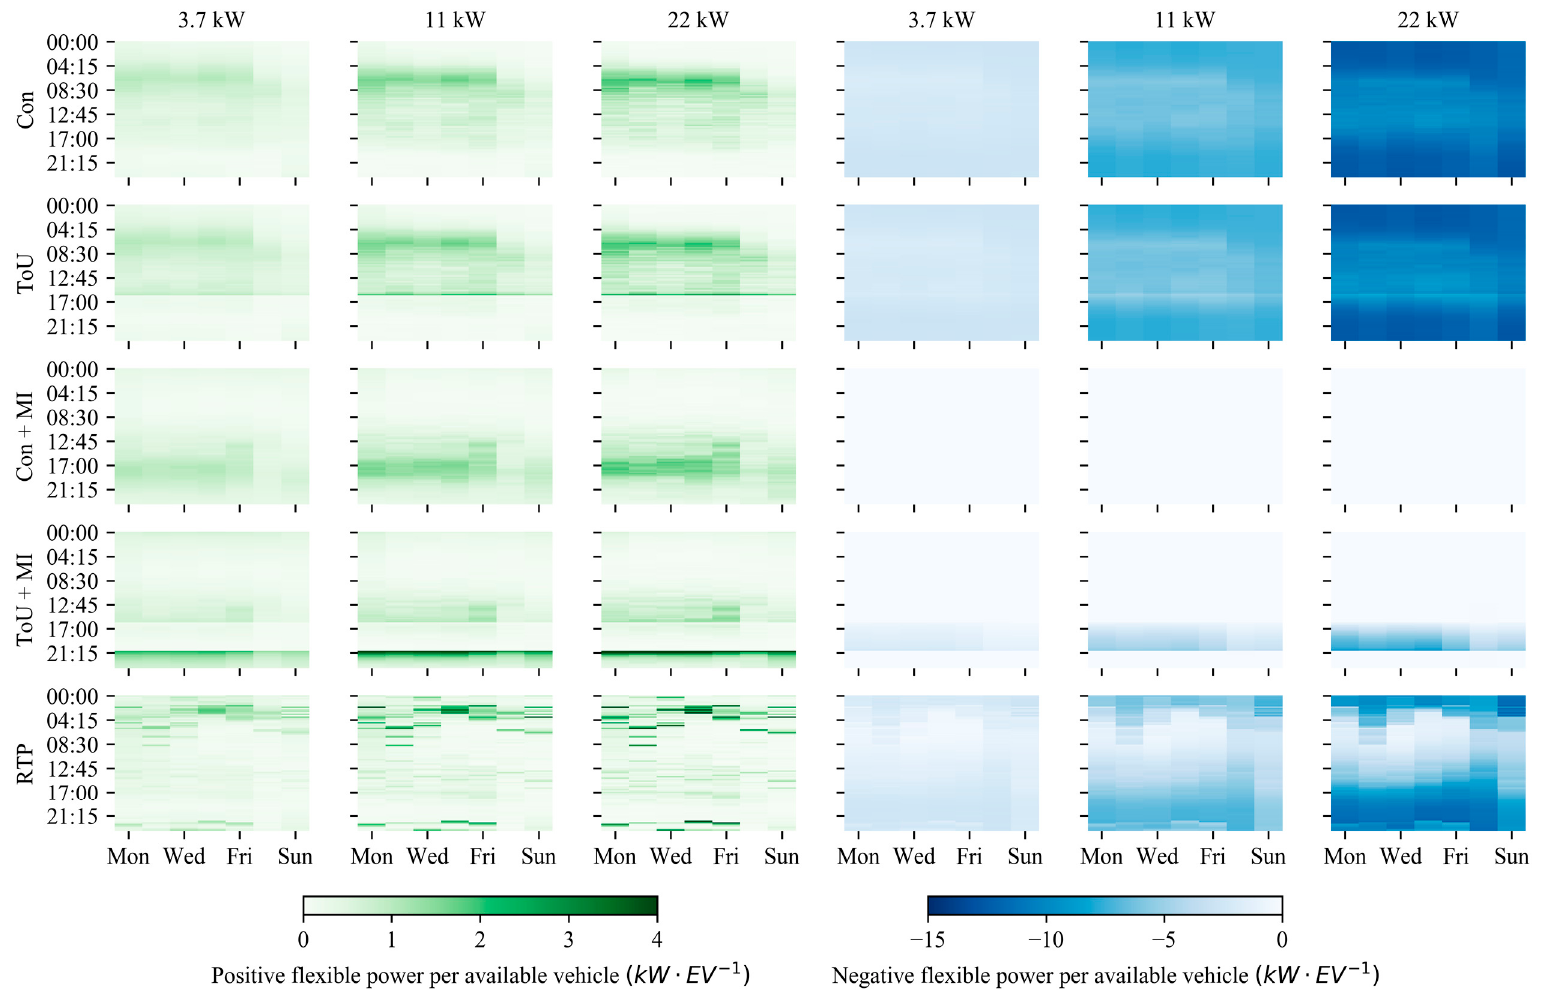
Figure 8. Resulting positive and negative flexible power per available EV. These results are based on the GER MP vehicle availabilities, the five operating strategies { Con , ToU , Con + MI , ToU + MI , RTP }, and three maximal charging power levels {3.7, 11, 22 kW}.